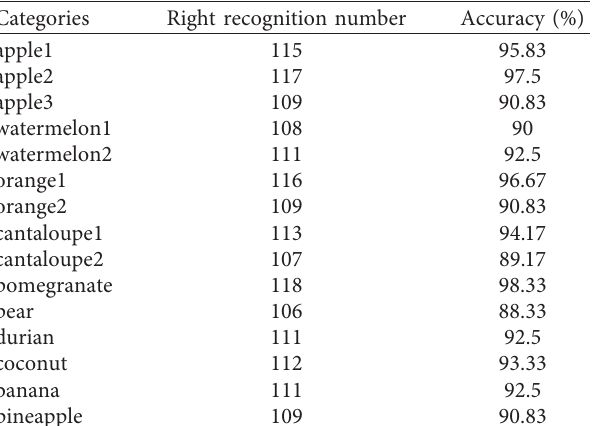
Figure 11: Influence of block overlap ratio on fruits boxes Table 1: Recognition accuracy of different categories.